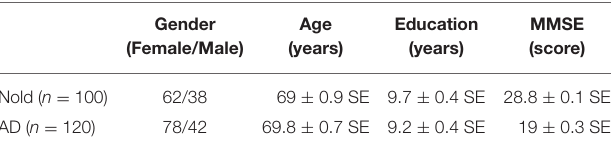
TABLE 1 | Demographic and clinical data of normal elderly (Nold) subjects and Alzheimer’s disease (AD) patients.